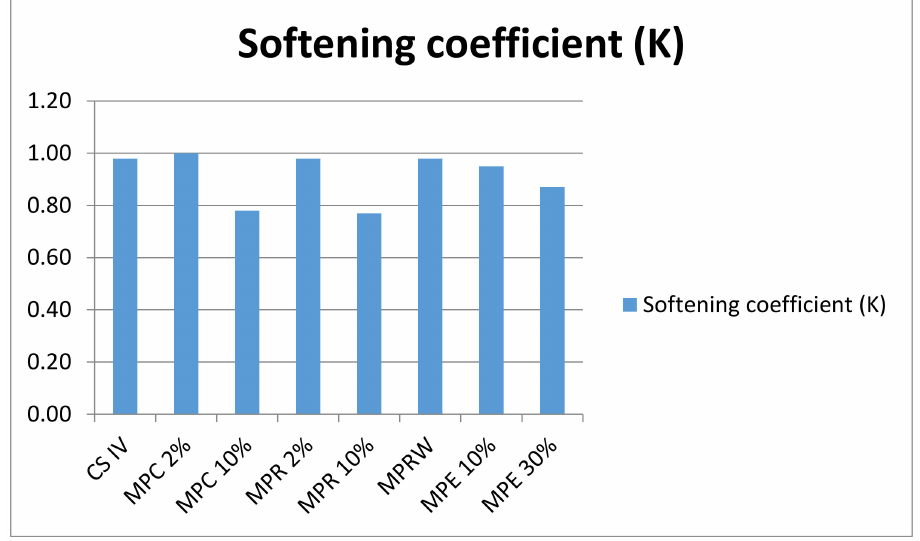
Figure 6. Average softening coe ffi cient values at 28 days for the mortars investigated in the research